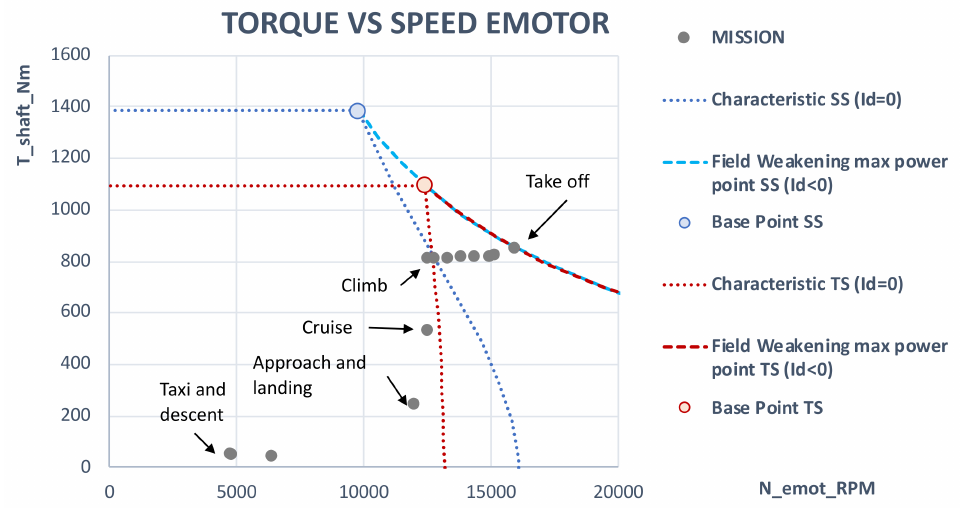
Figure 15. Torque–speed characteristics (blue: steady-state (SS) optimization, red: transient state (TS) optimization). Both optimized machines (with both thermal models) use field-weakening